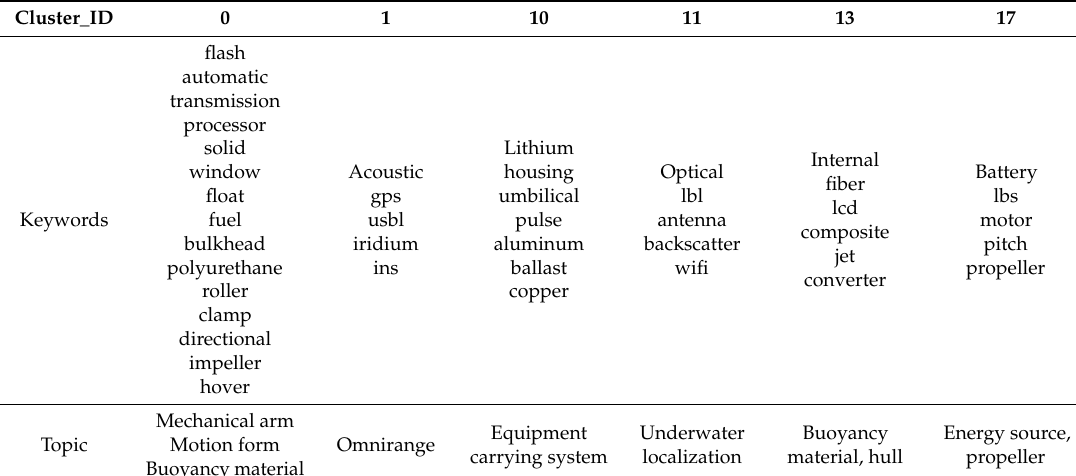
Table 2. An example of K-means clustering results of technology keywords.